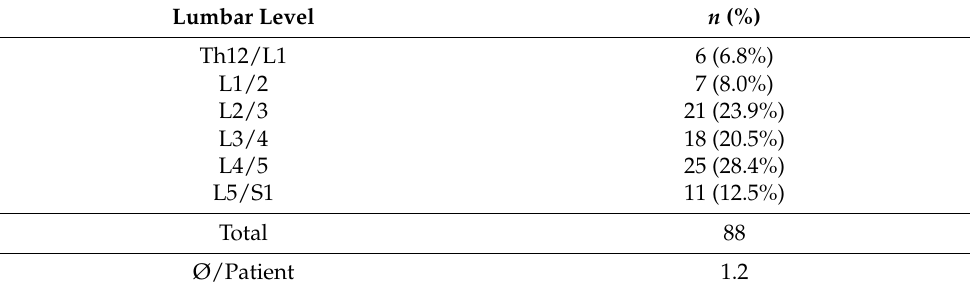
Table 4. Affected lumbar